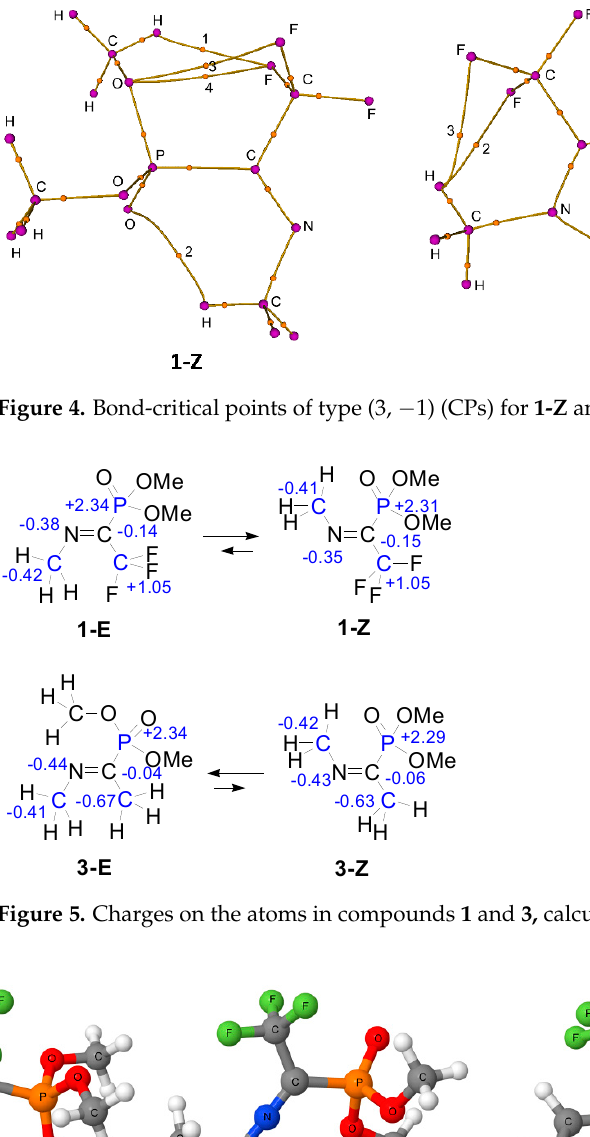
atoms (see ESI, Figure S1, left). However, the absence of the corresponding bond-critical Figure 4. Bond-critical points of type (3, − 1) (CPs) for 1-Z and 1-E .